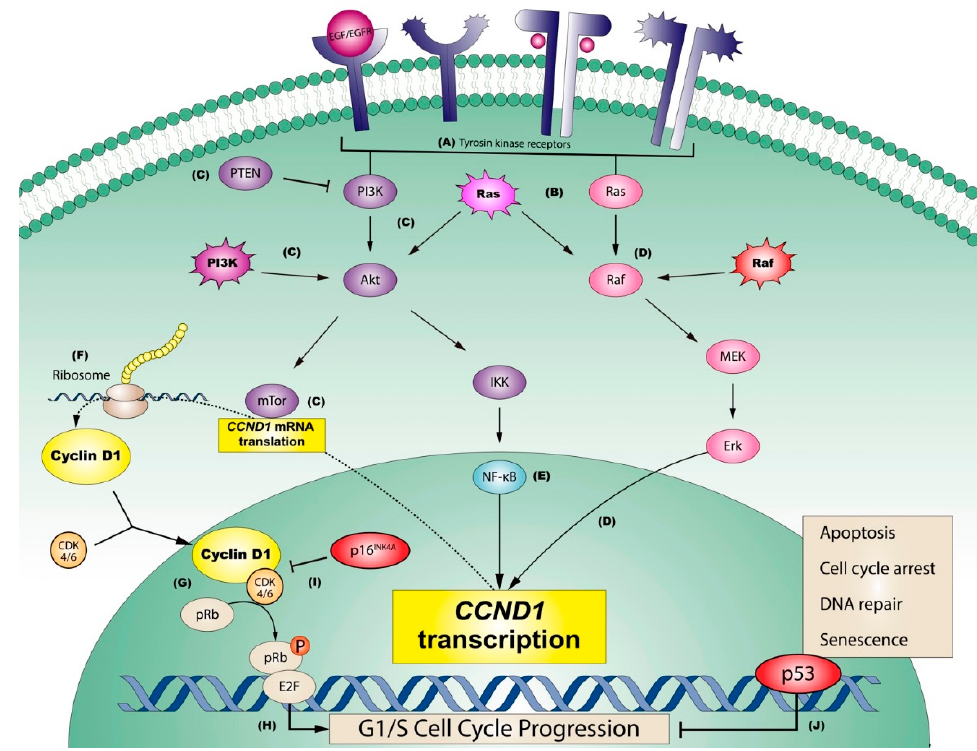
Figure 5. Graphic representation of the most relevant pathways regulating sustaining proliferative signaling in oral squamous cell carcinomas. ( A ) Tyrosine kinase receptors (e.g., EGFR or ErbB2) may be activated on the cell membrane by extracellular growth factors (e.g., EGF) or by constitutive mutations of the genes that encode them. Consequently, ( B ) Ras is downstream activated through the stimulation of these receptors, although Ras can be also activated by mutations, representing an influential central point in oral carcinogenesis, able to stimulate two important downstream onco- genic pathways: PI3K (pathway graphically represented in purple) and/or MAPK (pathway graphically represented in pink). ( C ) The PI3K pathway (PI3K-Akt-mTor, green), which can be blocked by its potent supressor PTEN ( C ), regulates the downstream translation of CCND1 mRNA via mTor ( C ). This pathway can also be constitutively activated by PI3K mutations ( C ). In parallel, ( D ) the endpoint of the MAPK pathway (Raf-MEK-Erk; in pink), which can also be activated by the constitutive mutation of Raf ( D ), is the Erk-mediated transcriptional activation of CCND1 ( D ). A third key pathway in the oncogenic activation of cyclin D1 is ( E ) NF-kB (in blue), which can be ac- tivated by IKK, as a consequence of PI3K pathway activation. ( F ) CCND1 transcriptional activation mediated by ERK, and the mTor-mediated translation of its messenger RNA, are both essential for the ribosomal synthesis of cyclin D1, which forms complexes with its binding partners, CDK4/6, that finally translocate to the nucleus. ( G ) Nuclear Cyclin D1-CDK4/6 complexes subsequently ac- tivate the retinoblastoma pathway, in which the release of transcription factors E2F is induced by the translocation of a phosphato group, ( H ) with progression from the G1 to the S phase of the cell cycle. The activation of the retinoblastoma pathway can be prevented ( I ) through the potent inhi- bition of Cyclin D1-CDK4/6 by the product of tumor suppressor gene CDKN2A (i.e., p16INK4), blocking cell cycle advance, or alternatively by the tumor supressor p53 ( J ), which plays an im- portant role arresting cell cycle progression, repairing the damaged DNA or finally promoting apoptosis, in an effort to prevent sustaining proliferation in cancer cells (adapted with permission from [64]). 4.2. Evasion of Growth-Suppressive Signals and Development of Resistance to Cell Death In addition to proliferating, tumor cells should be able to evade the growth sup- pressor signals that are physiologically established in abnormally proliferating cells; they must also establish mechanisms that make them resistant to cell death, which are dis- tinctive features of cancer [1,2]. These actions are essentially achieved by dysregulating